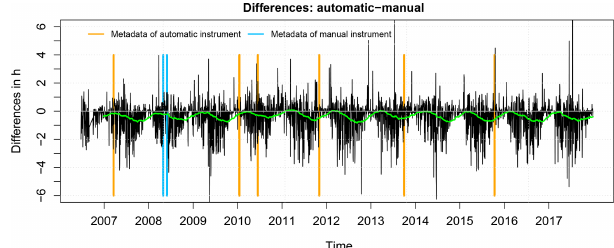
Figure 2. Differences of daily sunshine duration (automatic mi- nus manual observations) in hours at the station Schleswig. The green line is a moving average over 150 values; the vertical or- ange/blue line represents date of metadata information of the au- tomatic/manual instrument (replacements of instruments). Extreme outliers are not shown in this